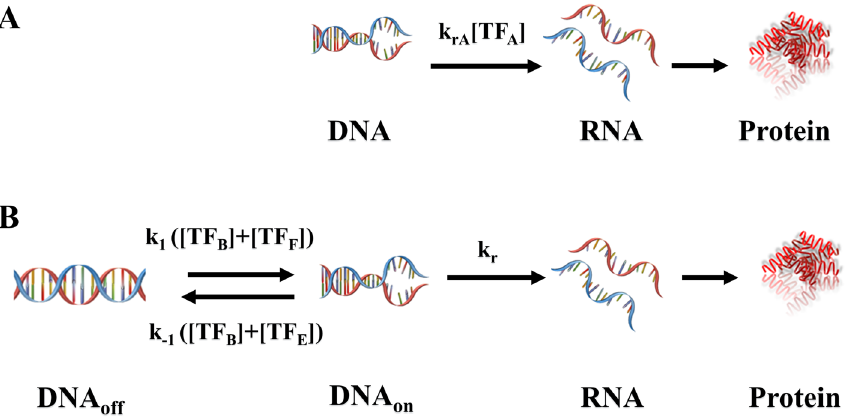
Figure 1. ( A ) In the system of amplitude modulation (AM), the transcription factor controls the transcription rate. ( B ) In the system of frequency modulation (FM), the transcription factors decide the flipping rate of DNA configuration.